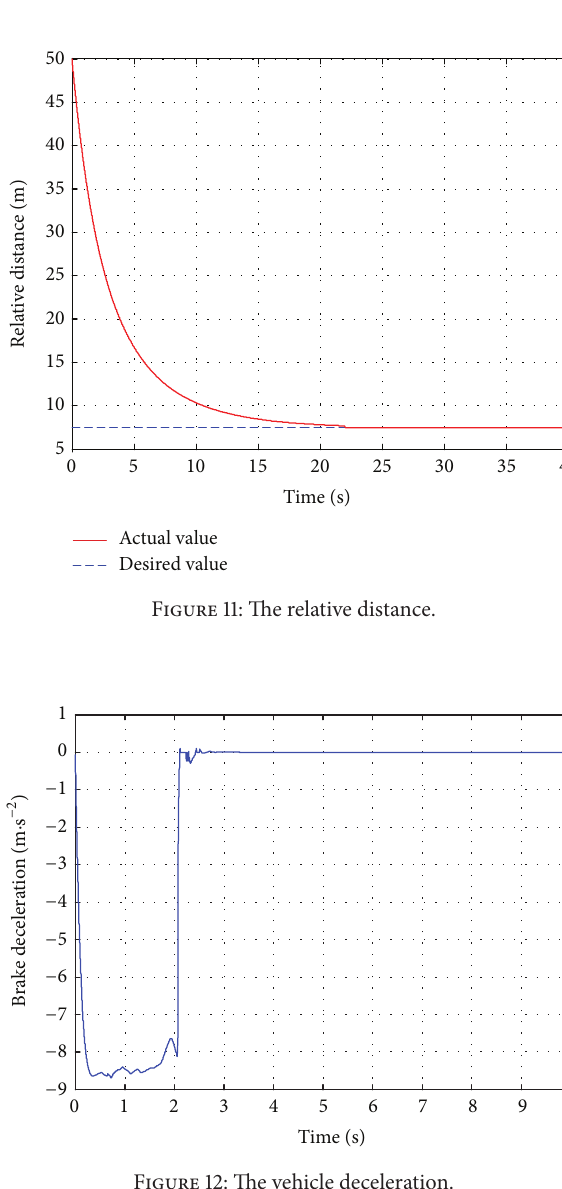
Figure 12: The vehicle